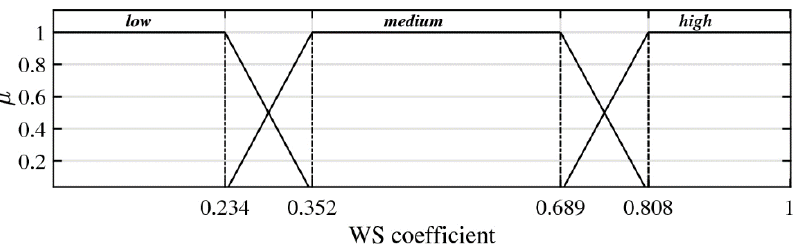
Figure 2. The concepts of different similarity of rankings by using trapezoidal fuzzy numbers [42] .